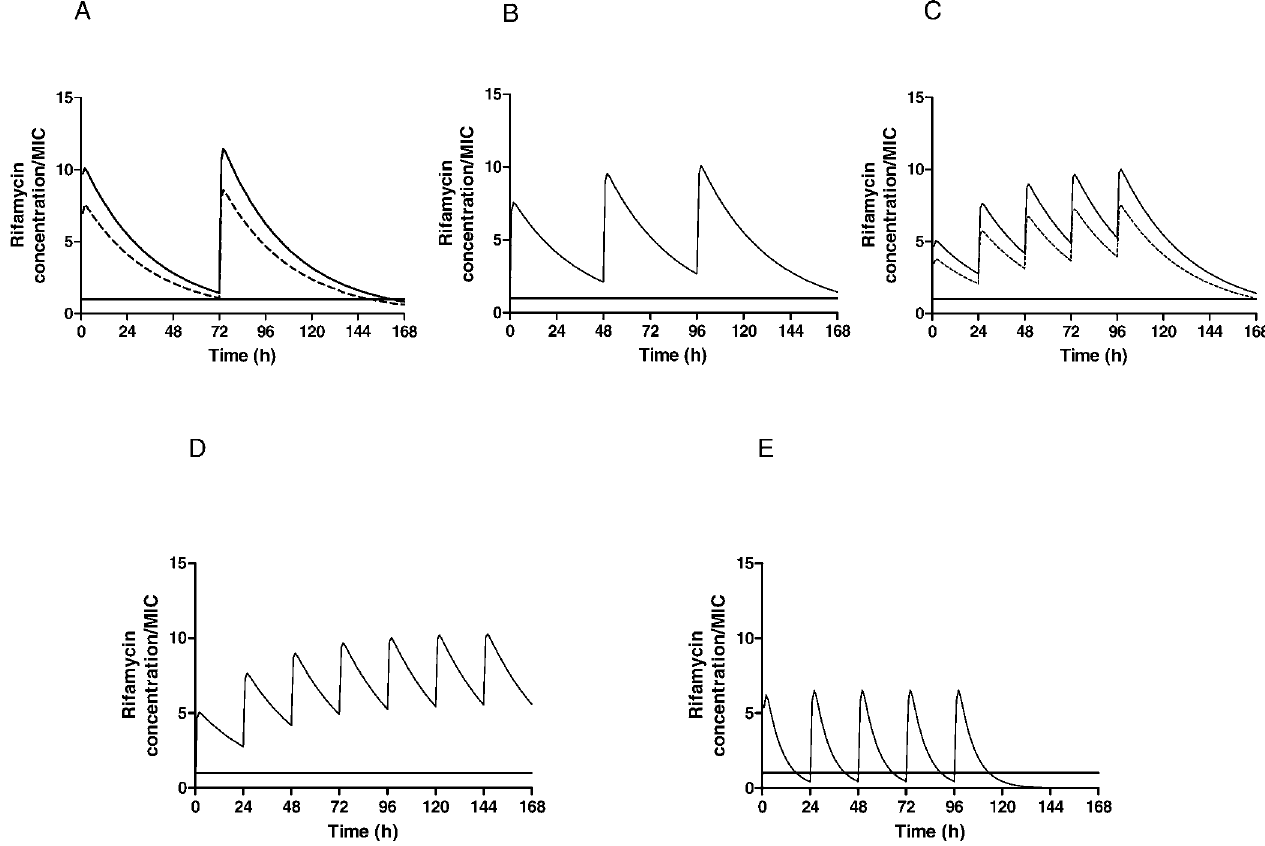
Figure 4. Steady-State Pharmacodynamic Simulations in Mice Treated with Rifapentine Compared with Rifampin Mice were treated with (A) twice-weekly (2/7) rifapentine 15 mg/kg (dashed line) and 20 mg/kg (solid line); (B) thrice-weekly (3/7) rifapentine 15 mg/kg; (C) daily (5/7) rifapentine 7.5 mg/kg (dashed line) and 10 mg/kg (solid line); (D) daily (7/7) rifapentine 10 mg/kg; and (e) daily (5/7) rifampin 10 mg/kg. Rifamycin concentrations are expressed in terms of free drug (2.5% and 17.5% free drug for rifapentine and rifampin, respectively). The free rifamycin concentration is below the MIC when the curve falls below the solid horizontal line. Pharmacodynamic parameter estimates are shown in Table 3.